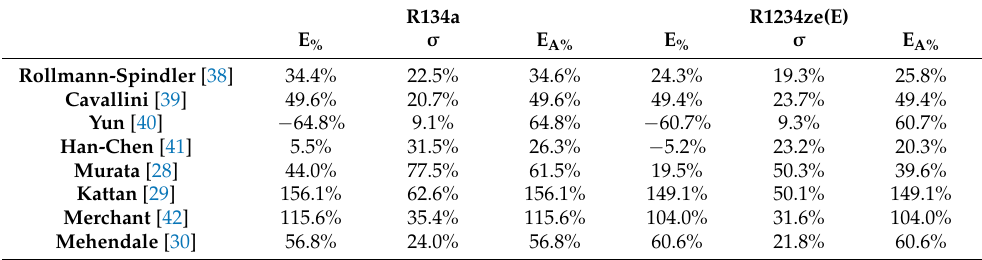
Table 6. Comparison between the experimental data concerning the heat transfer coefficient and the predictions provided by some of the correlations available in the open